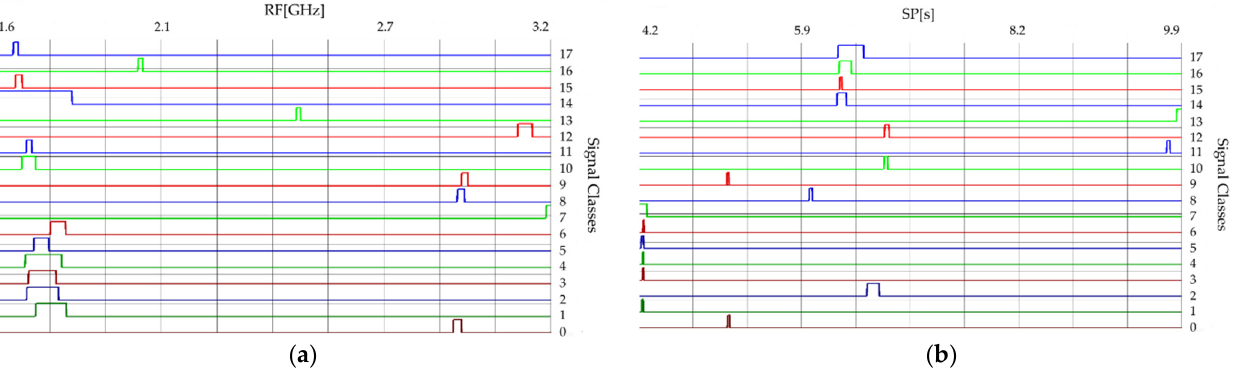
Figure 3. The confidence intervals of 18 classes of radars: ( a ) for parameter RF; ( b ) for parameter SP.